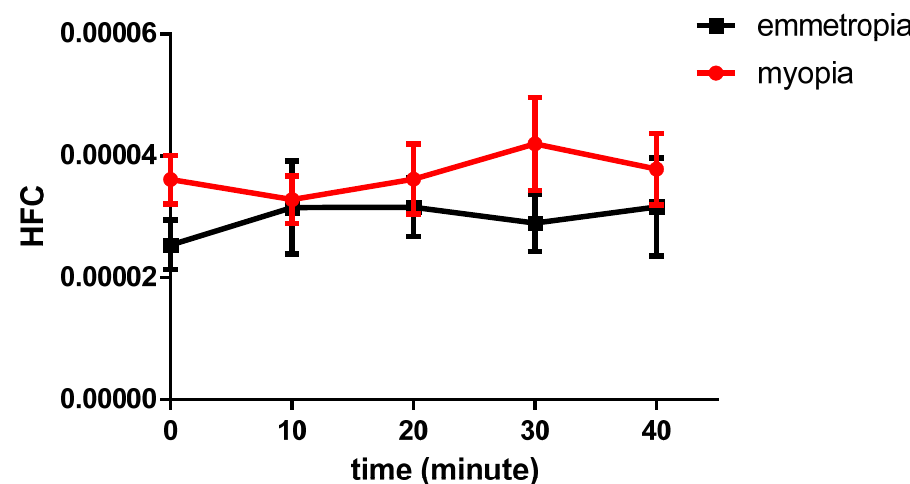
Figure 2. The HFC of the myopia group gradually increases with time and reaches a peak at 30 min, before a decline. The high-frequency component of myopic individuals was significantly different between the baseline and the periods of sustained near work of 10, 20, 30, and 40 min, as revealed by one-way repeated measures ANOVA ( p < 0.05).